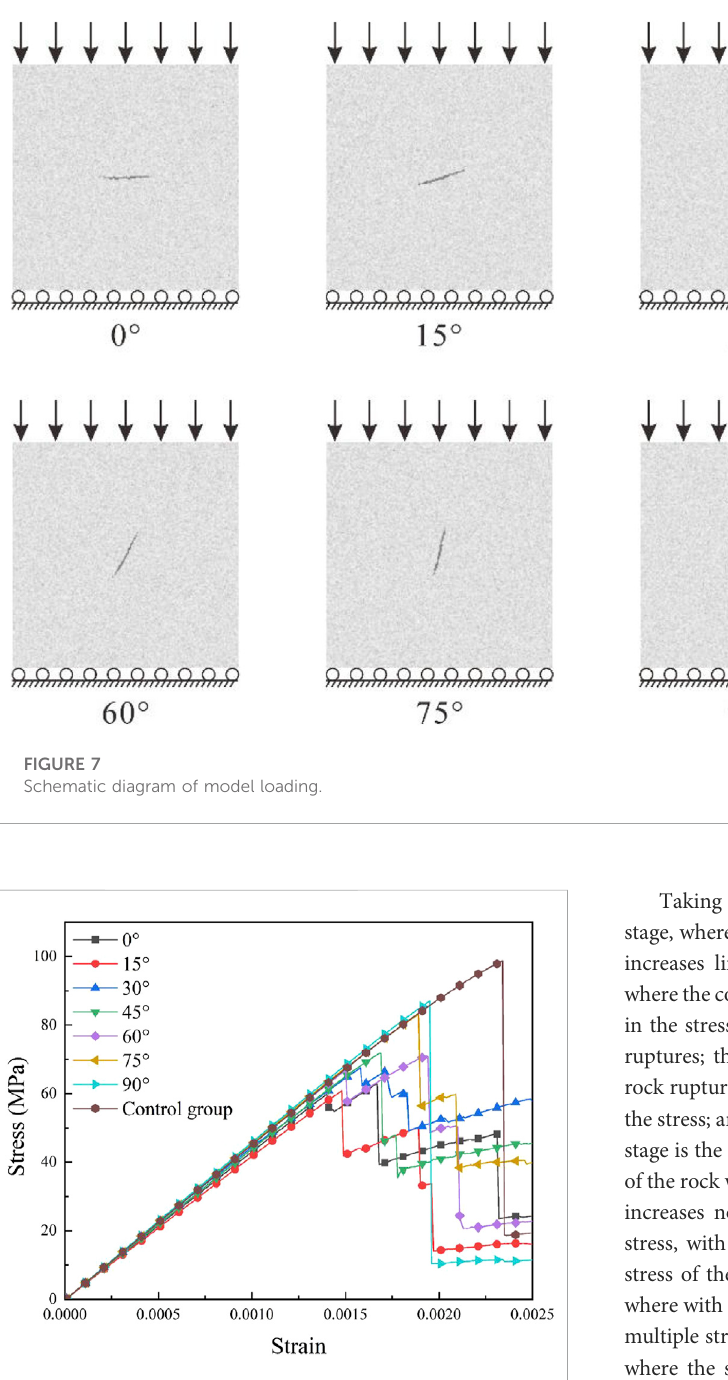
FIGURE 8 Stress-strain curve under